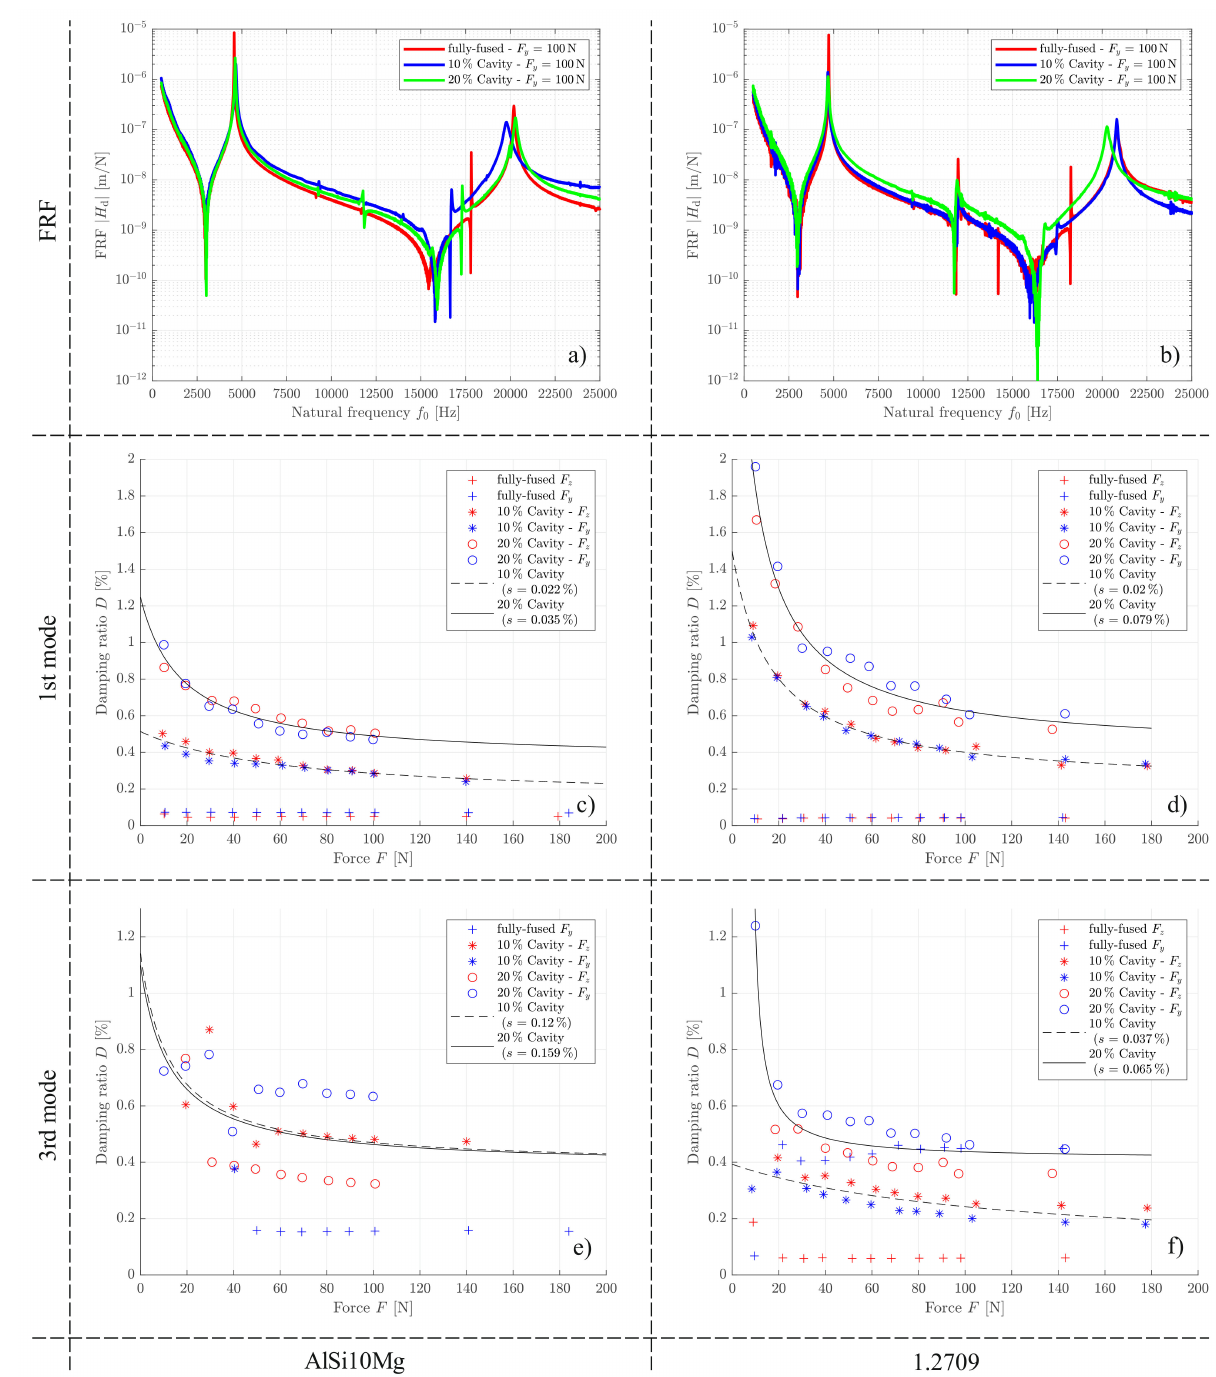
Figure 13. Frequency response functions and force-dependent damping characteristics (1st and 3rd mode) Left: outer dimensions: 20 × 20 × 150 mm 3 , parameter 18–20, material: AlSi10Mg, right: outer dimensions: 16.9 × 16.9 × 126 mm 3 , parameter 49–51, material: